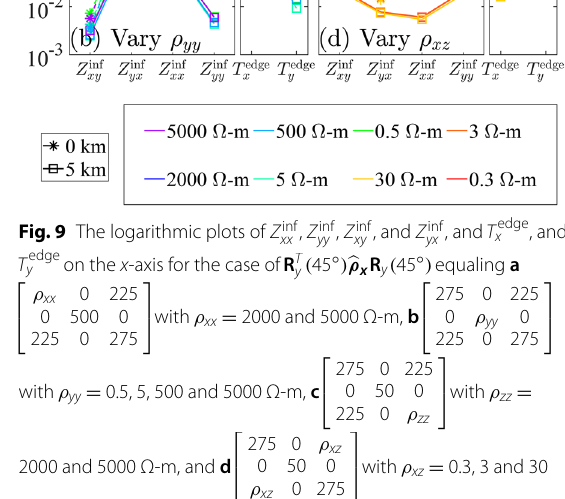
Ω‑m. The indices are all with reference to R T y ( 45 ◦